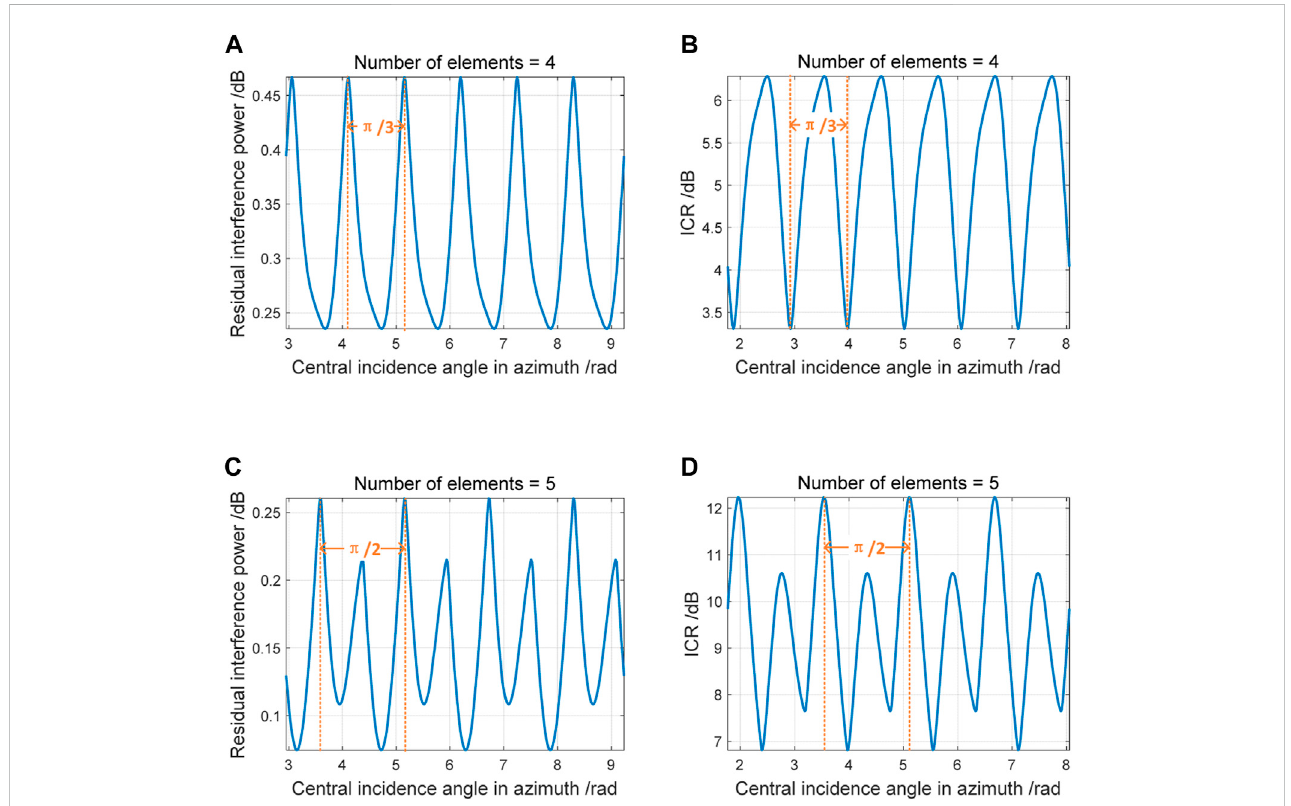
FIGURE 7 Azimuth periodicity of interference suppression performance. (A) Optimal residual interference power of four-element central UCA; (B) ICR of four- element central UCA; (C) Optimal residual interference power of fi ve-element central UCA; (D) ICR of fi ve-element central UCA.